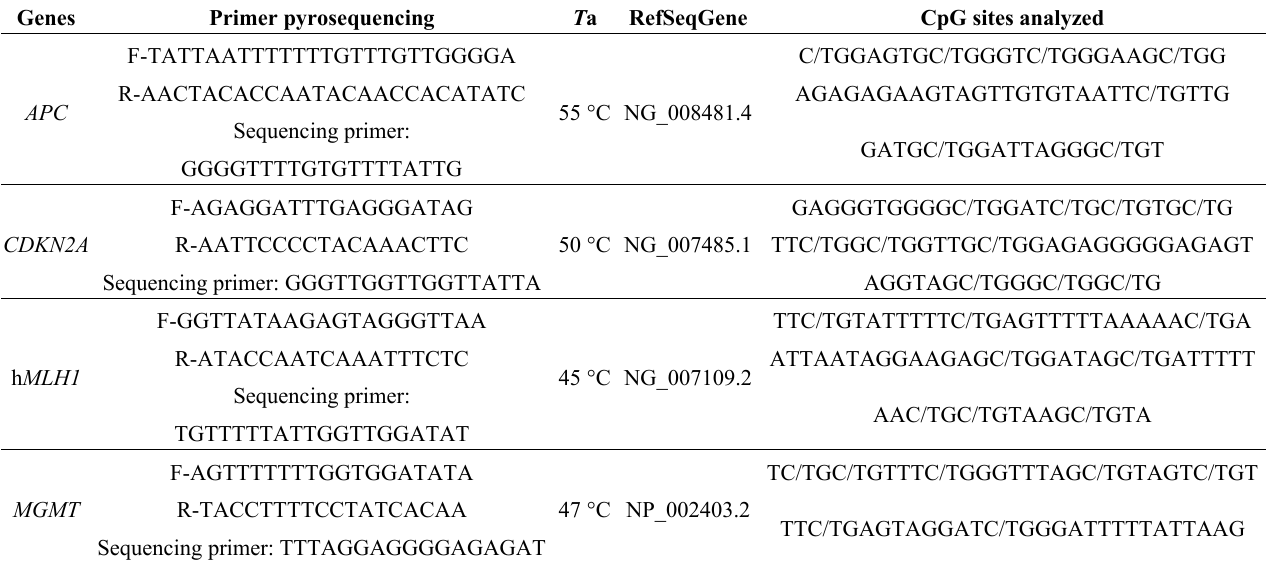
Table 3. Pyrosequencing conditions and analyzed